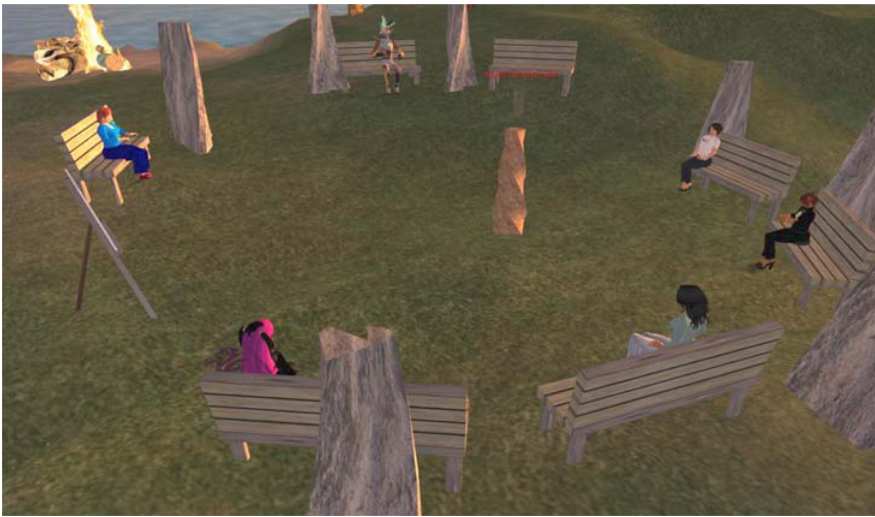
Figure 1. The meeting space in SL. Linden Research, Inc.